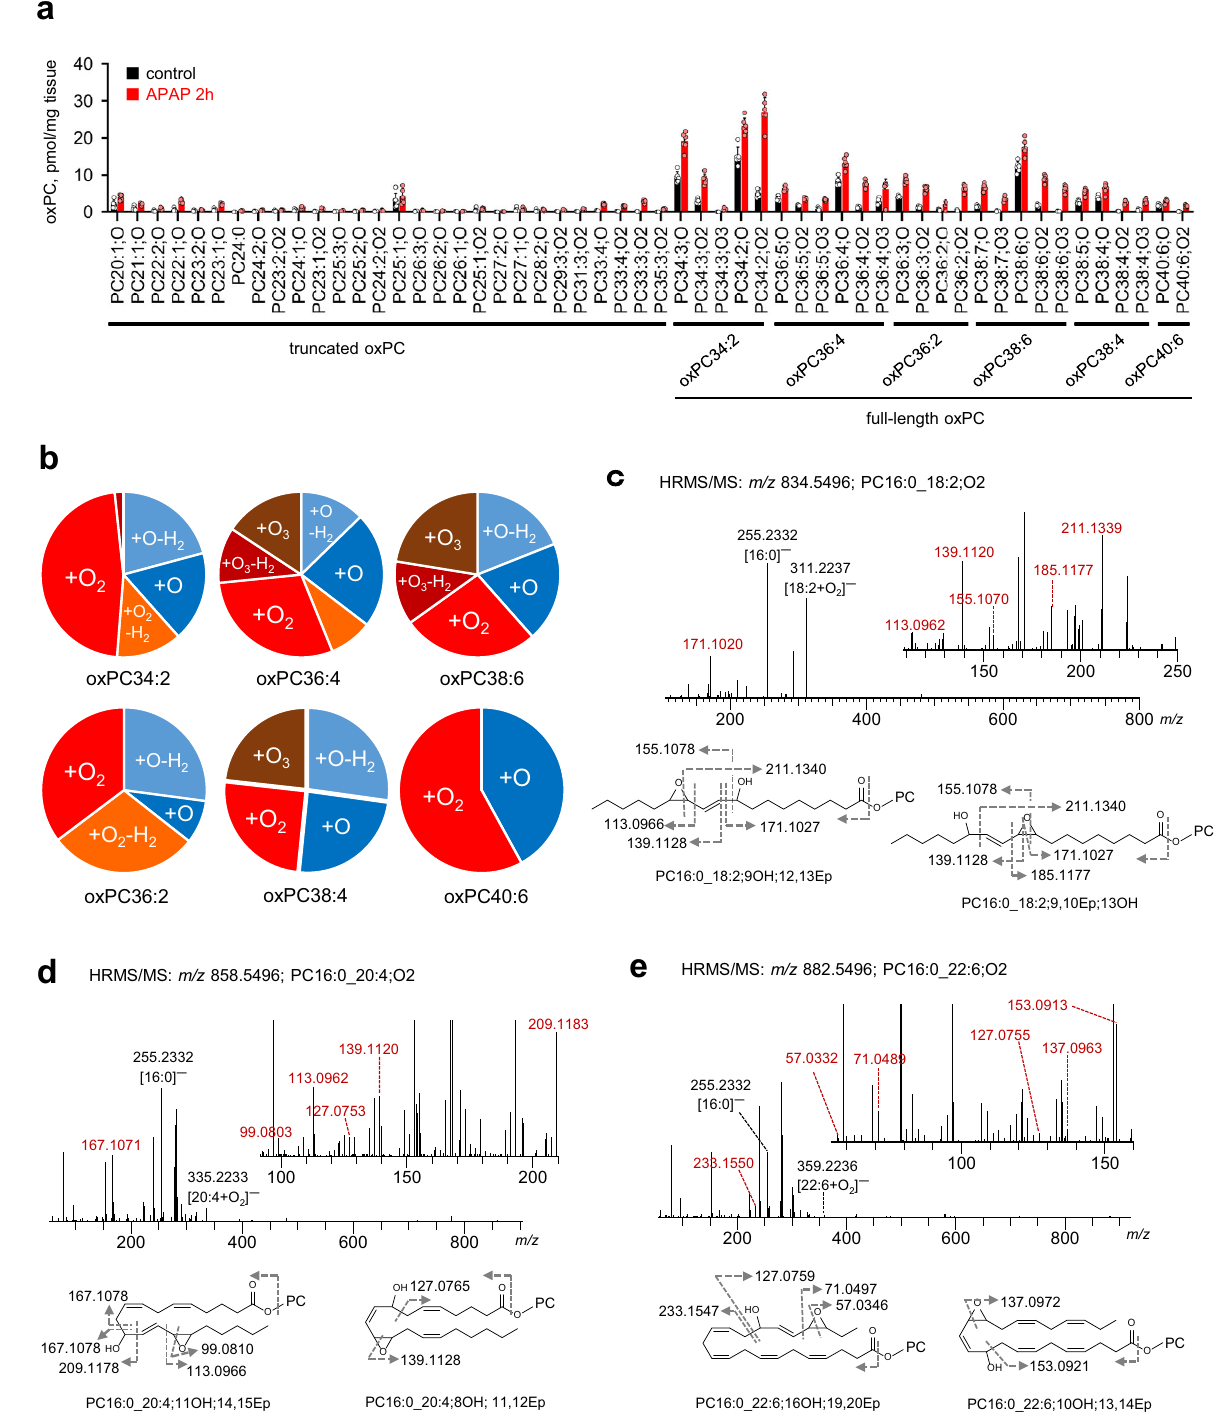
Fig. 4 Epoxide and/or hydroxide motif-containing PC16:0_PUFA;O2 with remarkably increased levels in the early phase of APAP-induced ALF. a Semiquanti fi ed concentrations of individual oxPCs in vehicle- (black) and 2-h APAP-treated (red) groups. The peak areas from extracted ion chromatogram for each oxPCs were determined by full-scan LC/HRMS in positive ion mode. The semiquantitative values were calculated using the ratio of the MS peak area of individual oxPCs to that of PC15:0/18:1- d 7 (internal standard). Data are presented as the mean + standard deviation of experiments repeated six times. b Distribution of individual full-length oxPCs (oxPC34:2, oxPC36:4, oxPC38:6, oxPC36:2, oxPC38:4, and oxPC40:6) in the liver of 2-h APAP-treated mice. The levels of oxPCs in the APAP-treated group exceeded those in the vehicle-treated group. Pale blue = PC PUFA;O-H2, blue = PC PUFA;O, orange = PC PUFA;O2-H2, red = PC PUFA;O2, deep red = PC PUFA;O3-H2, and brown = PC PUFA;O3. c – e LC/HRMS/MS identi fi cation and plausible chemical structures of PC16:0_PUFA;O2 in 2-h APAP-treated samples. HRMS/MS spectra of ions with m/z 834.5496 ( c ), 858.5496 ( d ), and 882.5496 ( e ) corresponding to PC16:0_18:2;O2, PC16:0_20:4;O2, and PC16:0_22:6;O2, respectively. In c – e , experiments were performed fi ve times. Source data are provided as a Source Data fi